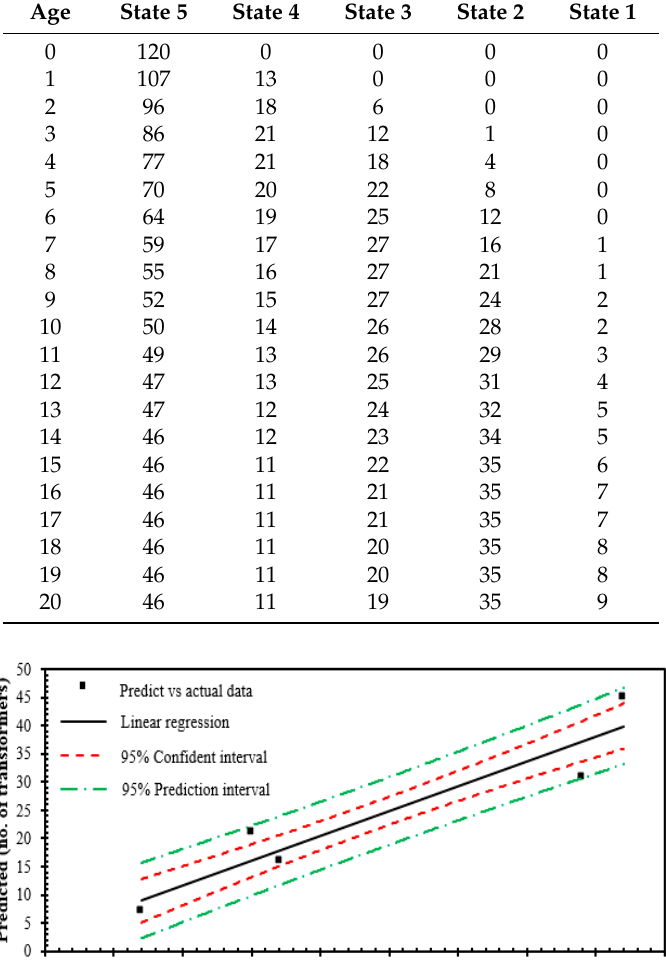
Table 7. Numbers of transformers in each of the states based on transition states for the year 2013/2014 with the maintenance policy model.